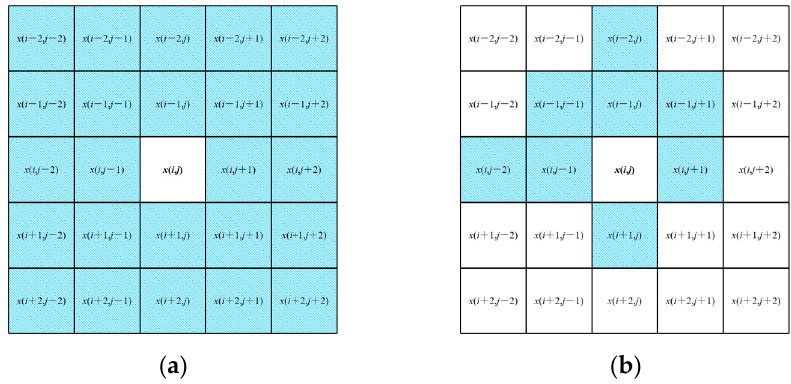
Figure 2. Training pixels of the target pixel x ( i , j ): ( a ) LP and ( b ) Ridge regression predictor. According to the prediction rule of the LS predictor, the prediction accuracy depends on the applicability of the trained prediction weights against the target pixel. Therefore, the training pixel should have strong local consistency with the target pixel. The proposed LS-ET predictor uses different training pixels based on the characteristic of the target pixel. Firstly, calculate four direction gradients of the target pixel x ( i , j ): horizontal gradient d h , vertical gradient d v , positive diagonal gradient d pd , and negative diagonal gradient d np by Equations